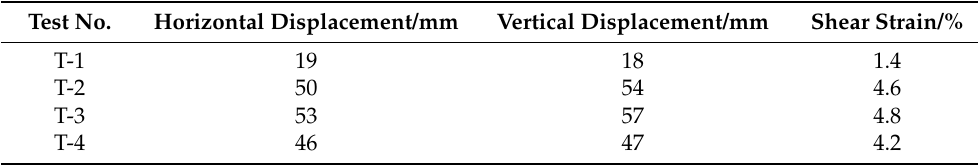
Table 3. The maximum displacement and shear strain at failure. Test No.